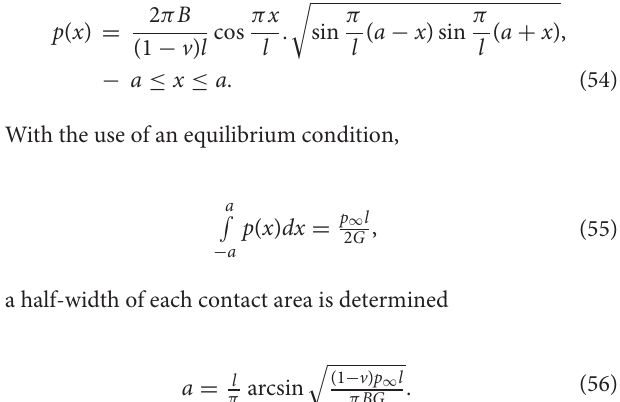
FIGURE 6 | Distribution of maximum tangential stress τ max in the cases of (A) smooth contact ( µ 0 0, Q / P 0), (B) contact with slip and adhesion = = ( µ 0 0.25, Q / P 0.15), and (C) sliding contact ( µ 0 = = n =